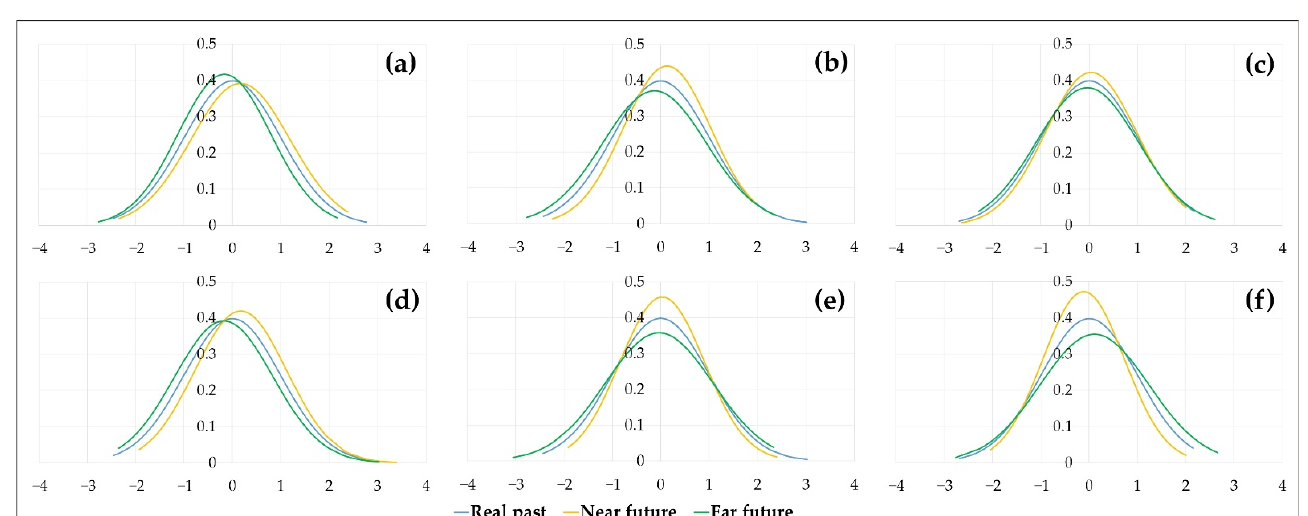
Table 10. Changes of SDI (x in Table) according to RCP 8.5.